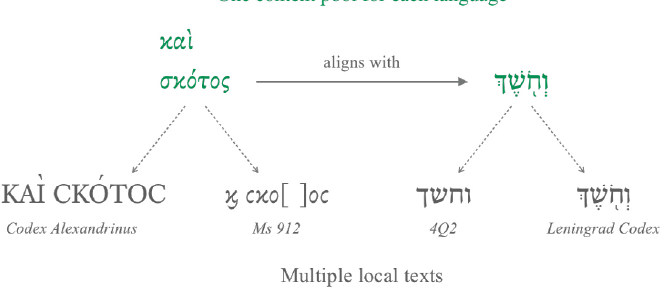
Figure 10: Aligning content pools allows for comparison between any local texts without duplication of data